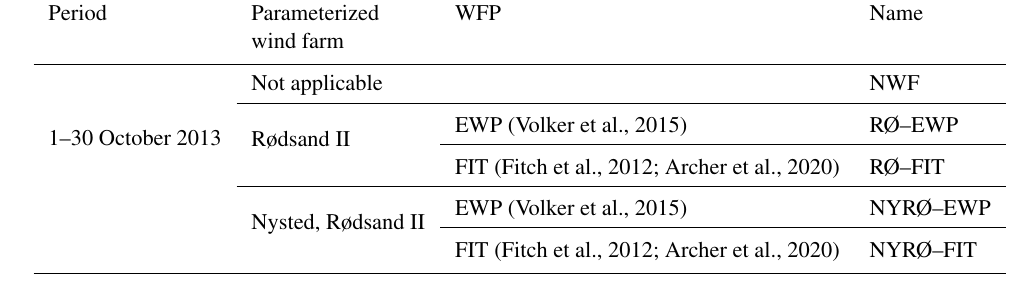
Table 7. Periods and scenarios covered by the WRF simulations. Period WFP Name